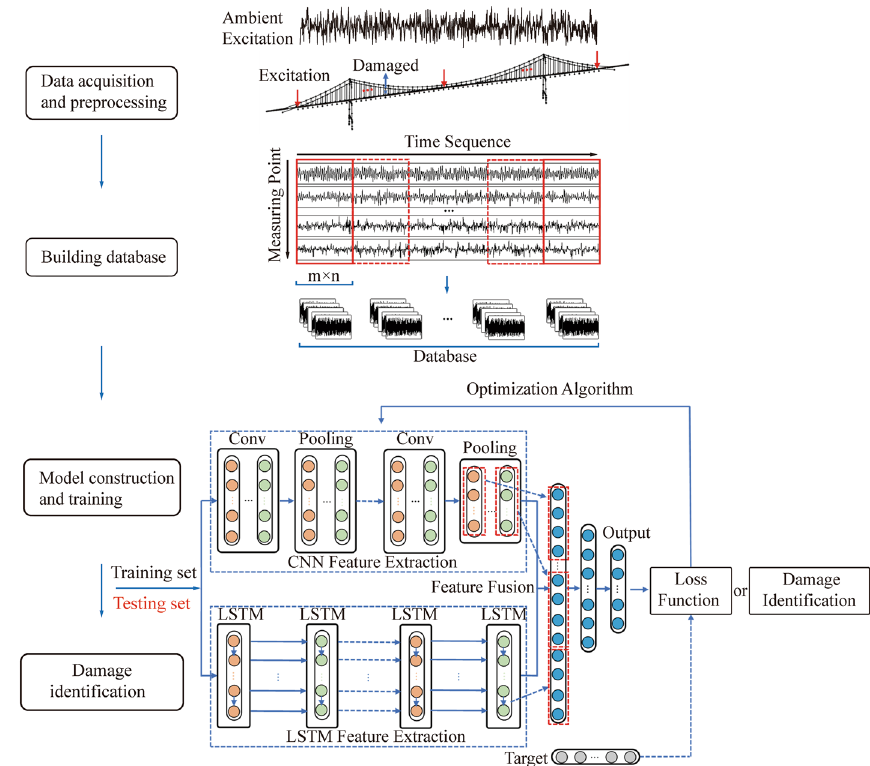
Fig. 8 The CNN‑LSTM‑based damage identification proposed by Fu et al